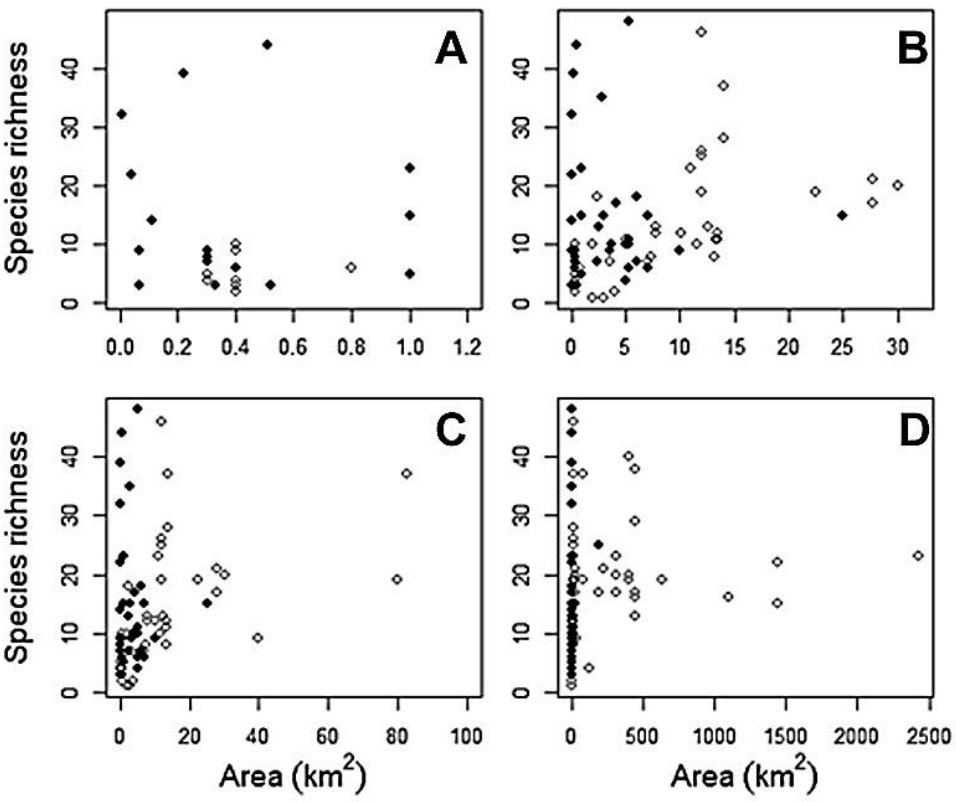
Figure 3. Total richness of microcrustaceans (copepods plus cladocerans) in function to the area of natural lakes ( ● , black circles) and reservoirs ( ○ , clear circles), considering lakes between: (A) 0 to 1.2 km 2 ; (B) 0 to 30 km 2 ; (C) 0 to 100 km 2 ; and (D) 0 to 2430 km 2 .